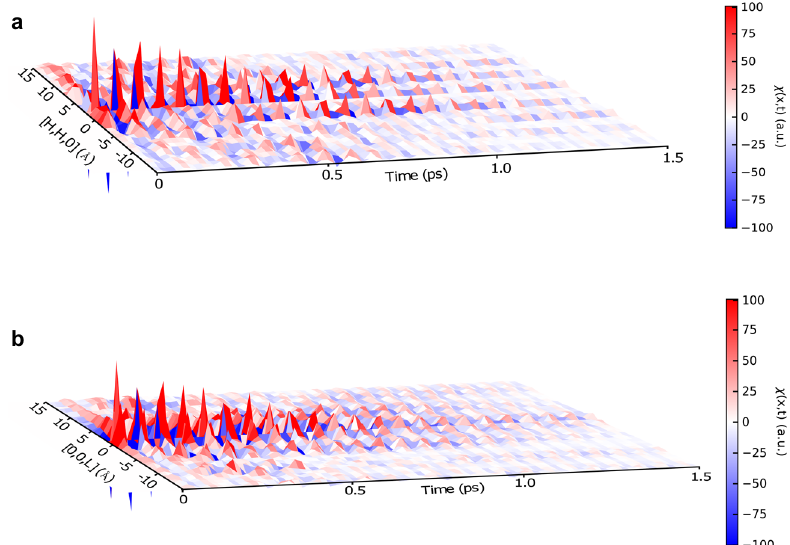
Fig. 6 Visualization of the lattice dynamics induced by a point source in silicon in the ( x , t ) domain. The dynamics a along the [1, 1, 0] direction and b along the [0, 0, 1] direction. The disturbance is still in the system at large instances, but the ripples' height is low. There is no dissipation of energy from the